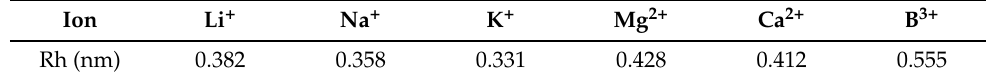
Table 2. Hydration radii of various ions in the salt solution